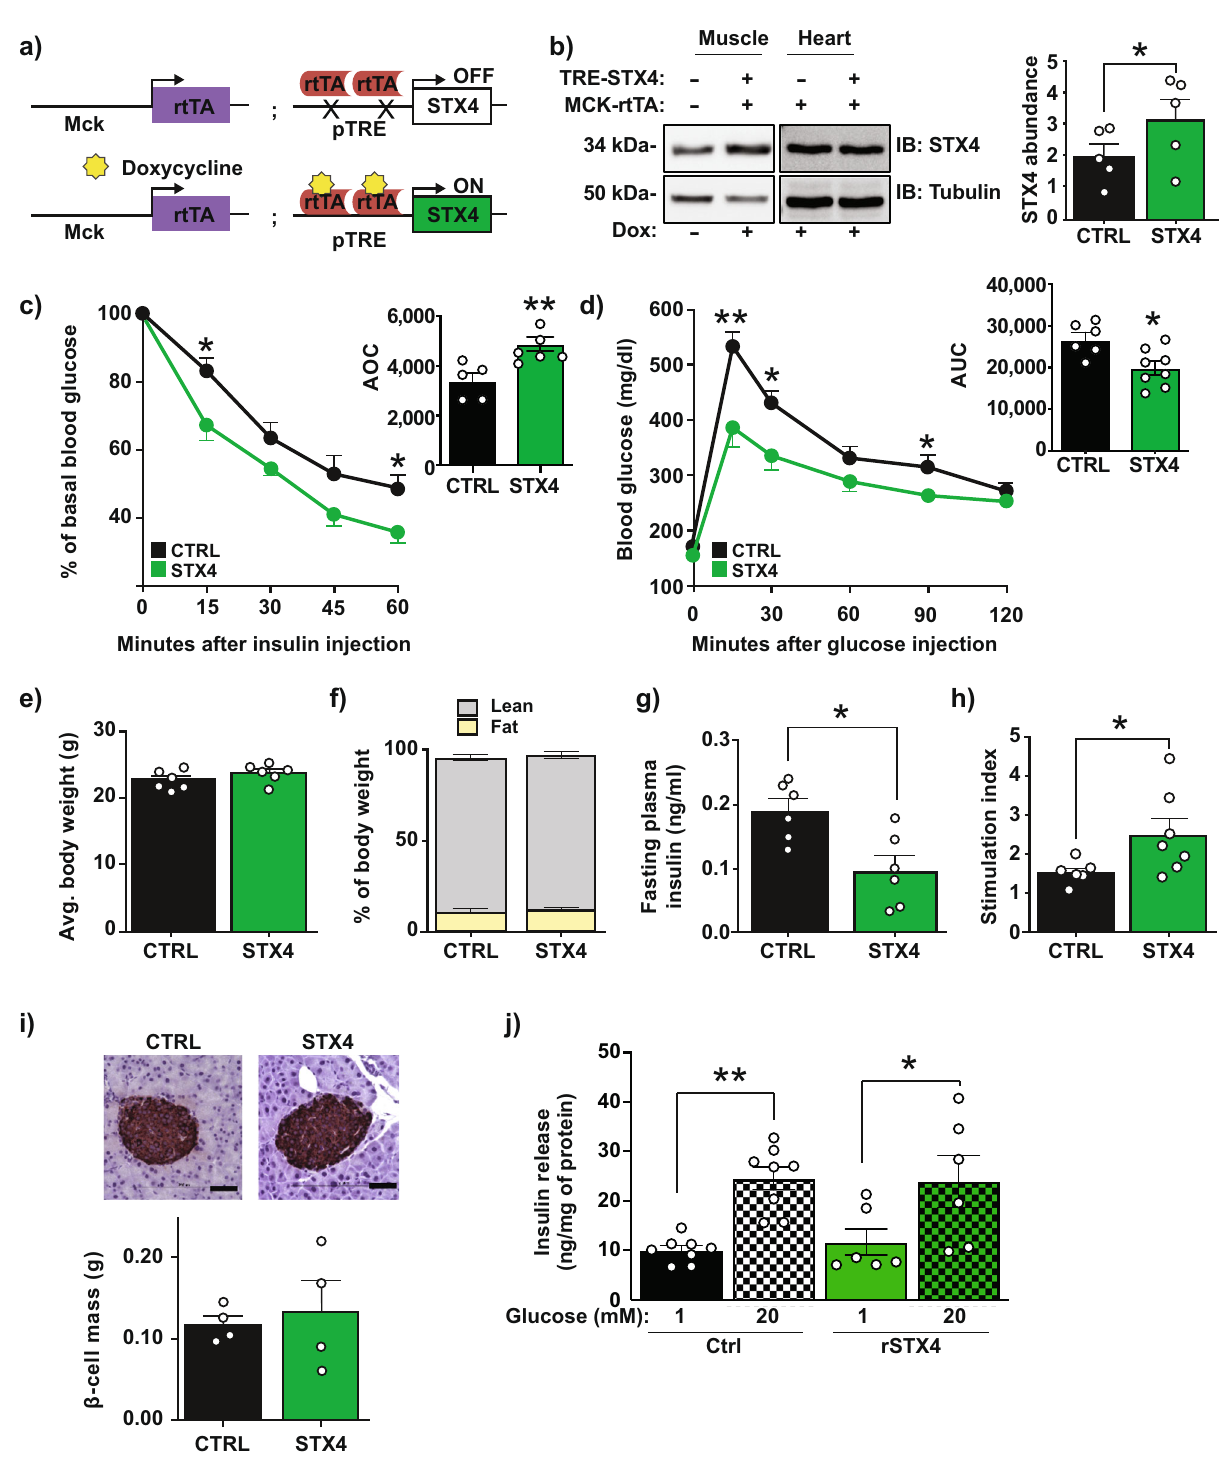
skeletal muscle L6 myoblasts were transiently transfected to overexpress STX4 or control DNA (empty vector), and the conditioned media (CM) taken from these skeletal muscle cultures was provided to rat beta cells (INS-1 832/13). No differences in baseline (1 mM glucose) or glucose-stimulated (20 mM glucose) insulin release were detected from beta cells treated with Ctrl- vs. rSTX4-enriched CM (Fig. 1j). Moreover, no differences in the plasma levels of glucagon, cholesterol, triglycerides or adiponectin were evident between skmSTX4tg